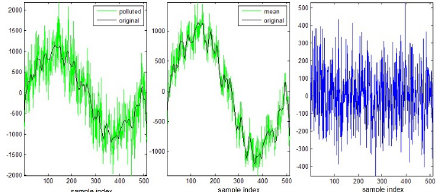
Figure 3. Signal of 7 periods. Left: 1-st period from the test signal before and after pollution with the most powerful noise; middle – mean signal and 1-st period from the original (non- polluted) signal; right – di ff erence between the mean signal and the 1-st period of the signal be- fore pollution.